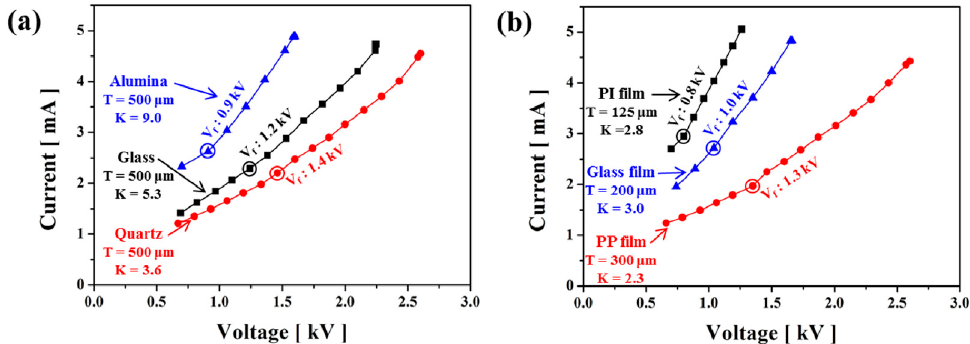
Figure 6. Current–voltage (I–V) graphs for the solid plates ( a ) and polymer films ( b ).